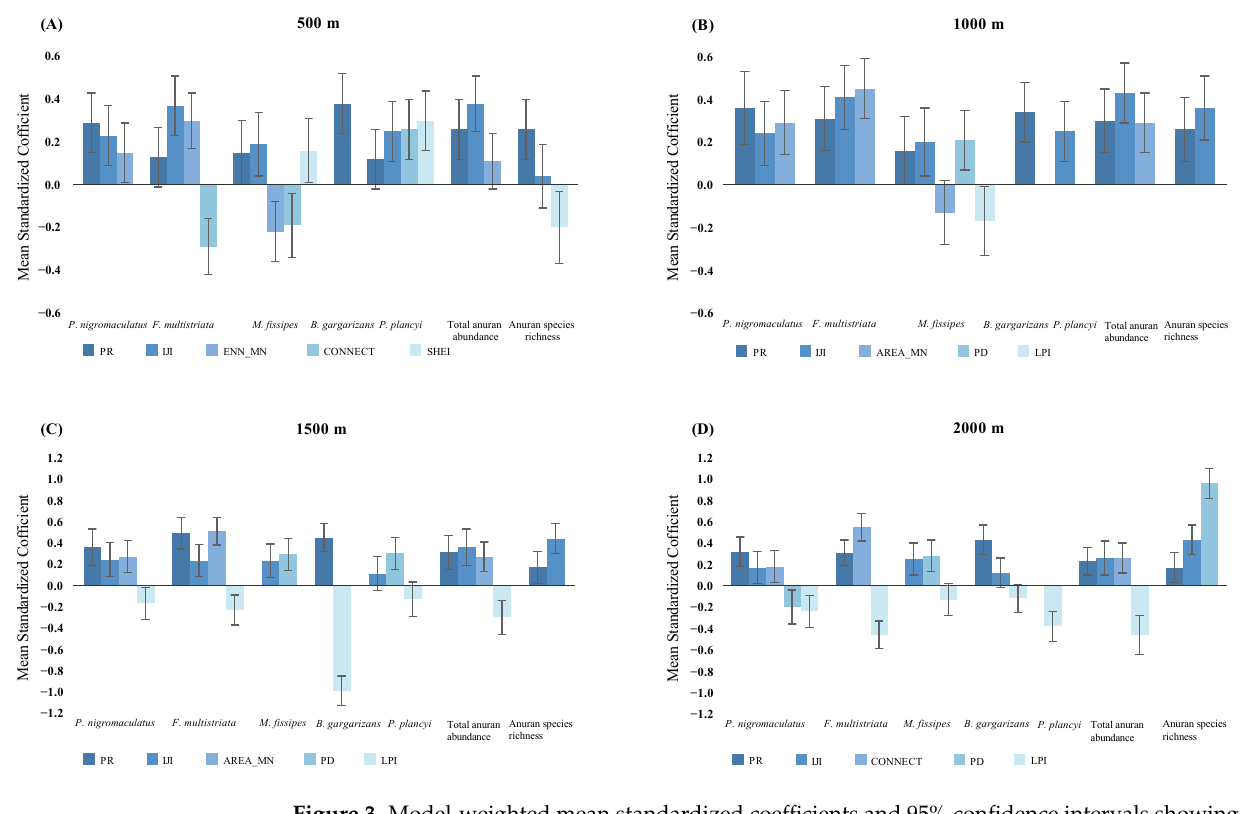
Figure 3. Model-weighted mean standardized coefficients and 95% confidence intervals showing the direction and relative magnitude of the effects of landscape variables (PR, IJI, ENN_MN, CONNECT, SHEI) on 5 anuran species, anuran species richness and abundance at different radii in urban landscapes in Shanghai. All possible models were estimated, using generalized linear modeling. Each coefficient was model-averaged across estimates from all models containing that coefficient. Note that landscape variables differed between the models at different radii. ( A ) 500 m radius; ( B ) 1000 m radius; ( C ) 1500 m radius; ( D ) 2000 m